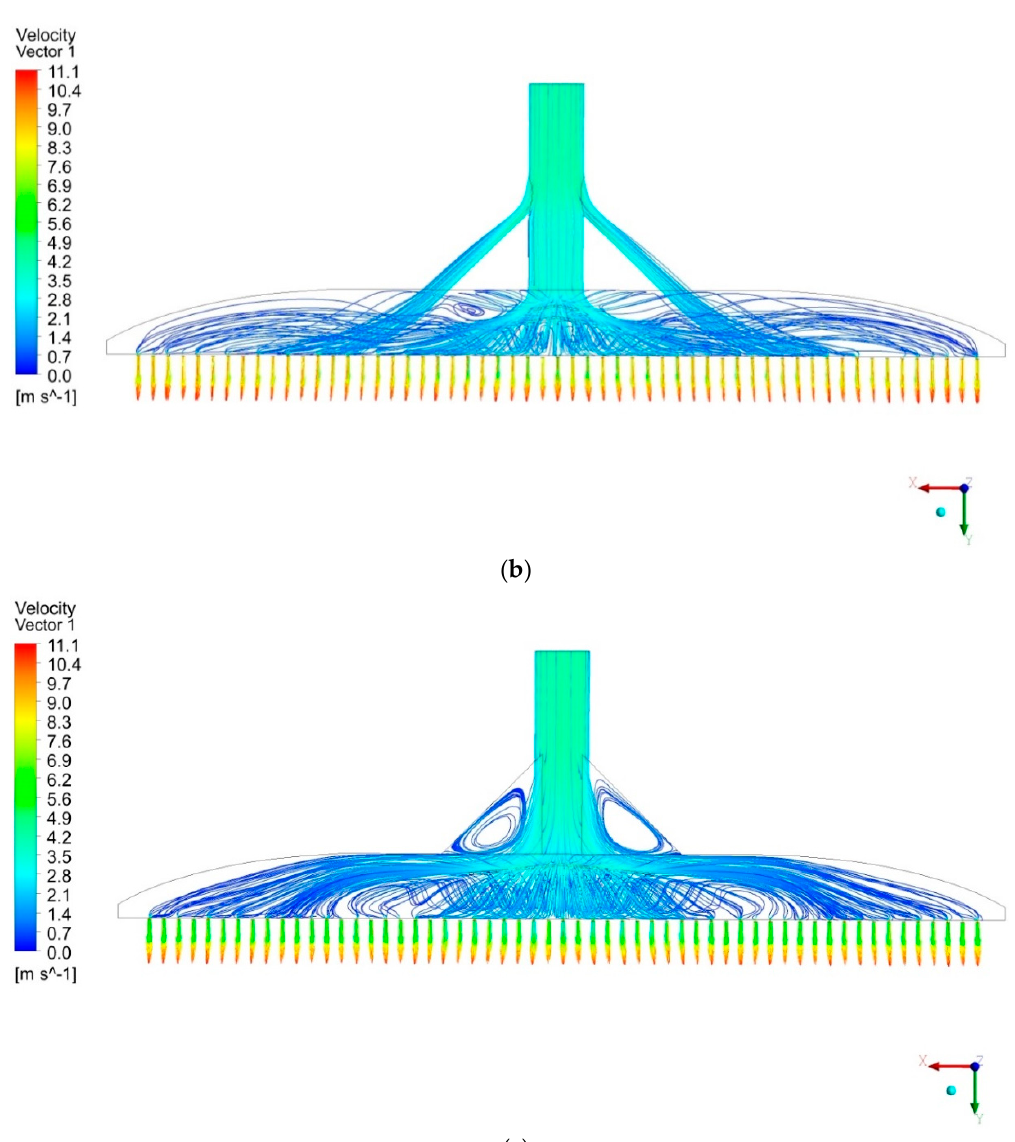
Figure 8. Inner streamlines and velocity vectors at the outlet of the three new gas torches: ( a ) model 1; ( b ) model 2; ( c ) model 3.